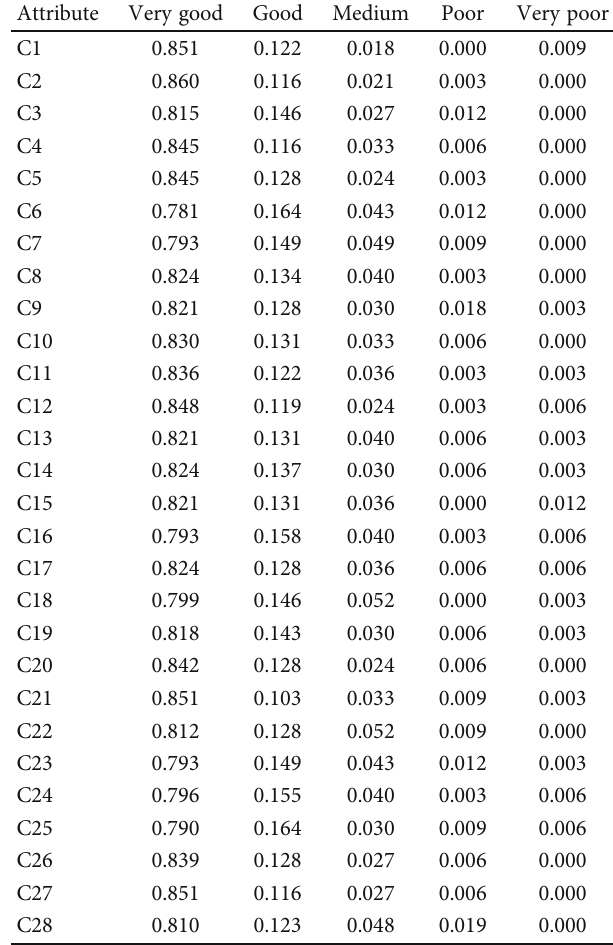
Table 6: C6 – C9 and C15 – C28 attribute judgment